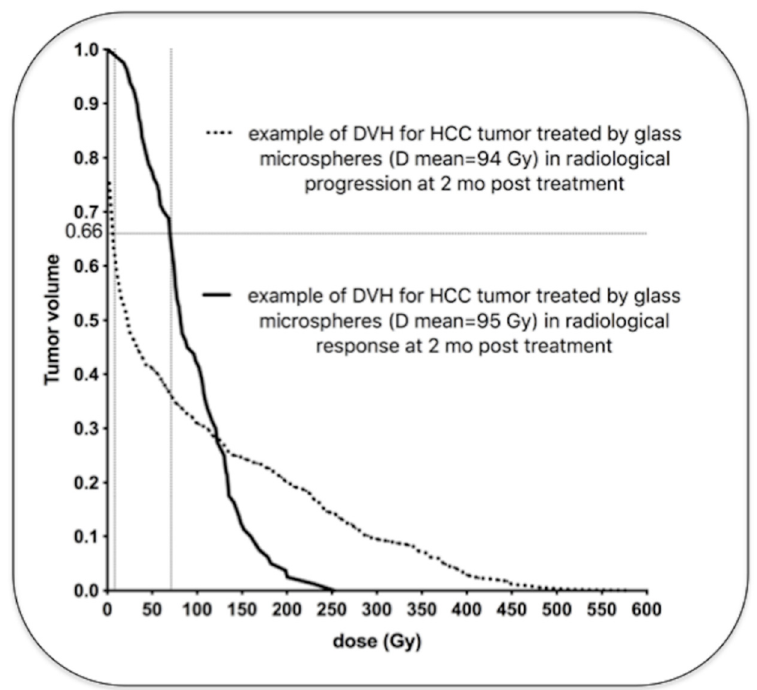
Figure 4. Examples of two HCC tumors treated with glass microspheres with similar mean absorbed doses (94 and 95 Gy) but very different dose distributions (personal data). One tumor (dotted line) received a very low dose in a large part of the tumor volume (more than 5 Gy in 66% of the tumor volume), and was in radiological progression two months later. The other tumor (solid line) received a high dose in a large part of the tumor volume (more than 69 Gy in 66% of the tumor volume) and was in radiological response two months later. Note that the cluster with the highest local dose